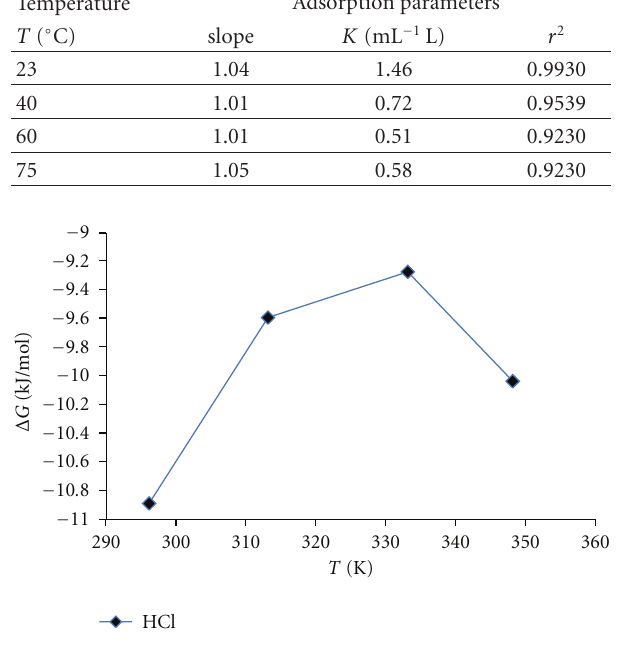
Figure 3: The variation of Δ G ads with T